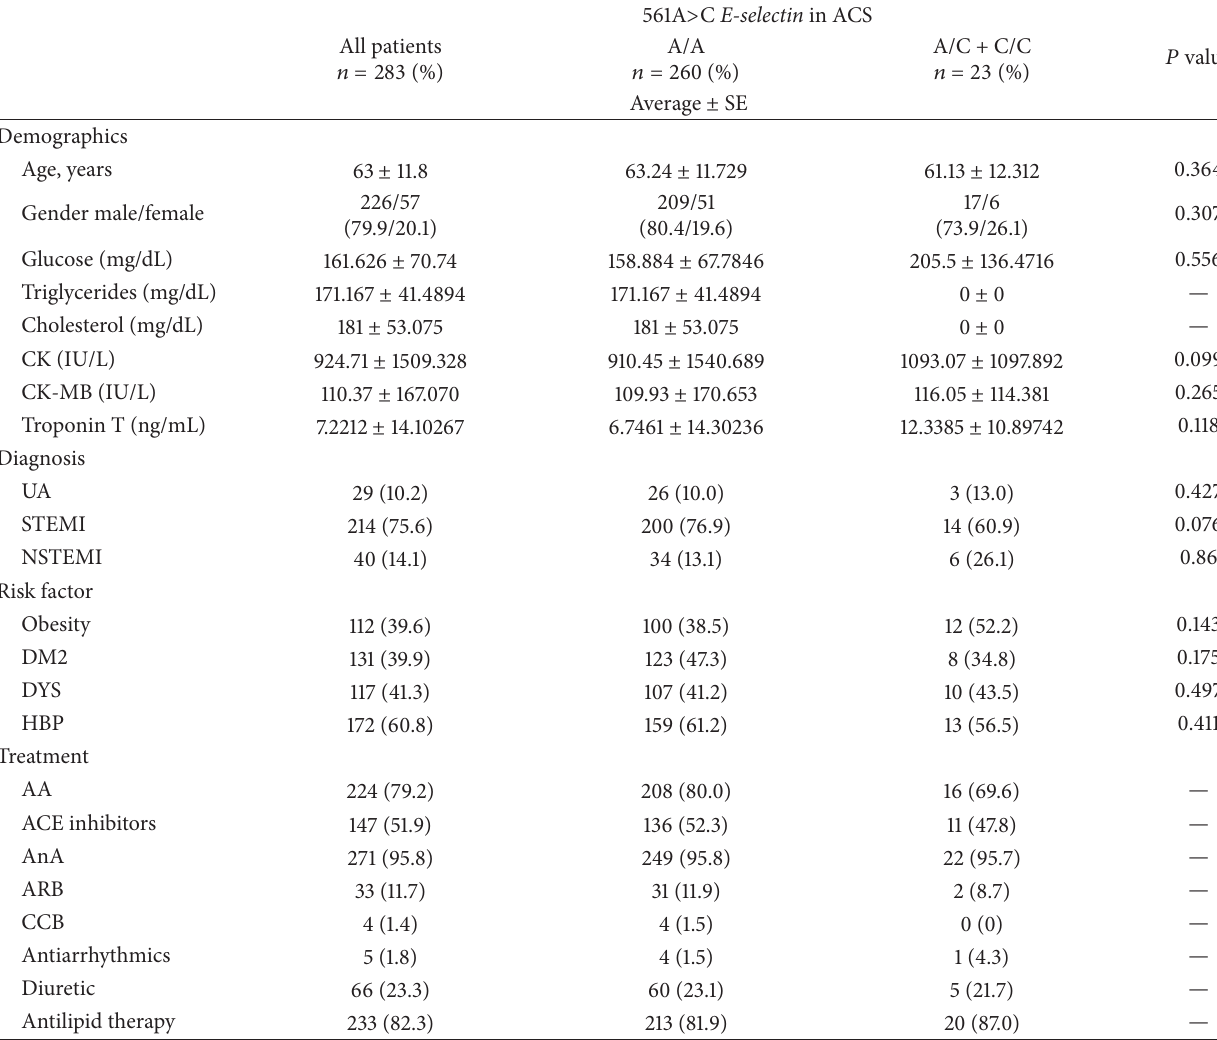
Table 1: Demographic and clinical characteristics in ACS according to rs5361 (561A > C) E-selectin polymorphism following a dominant genetic